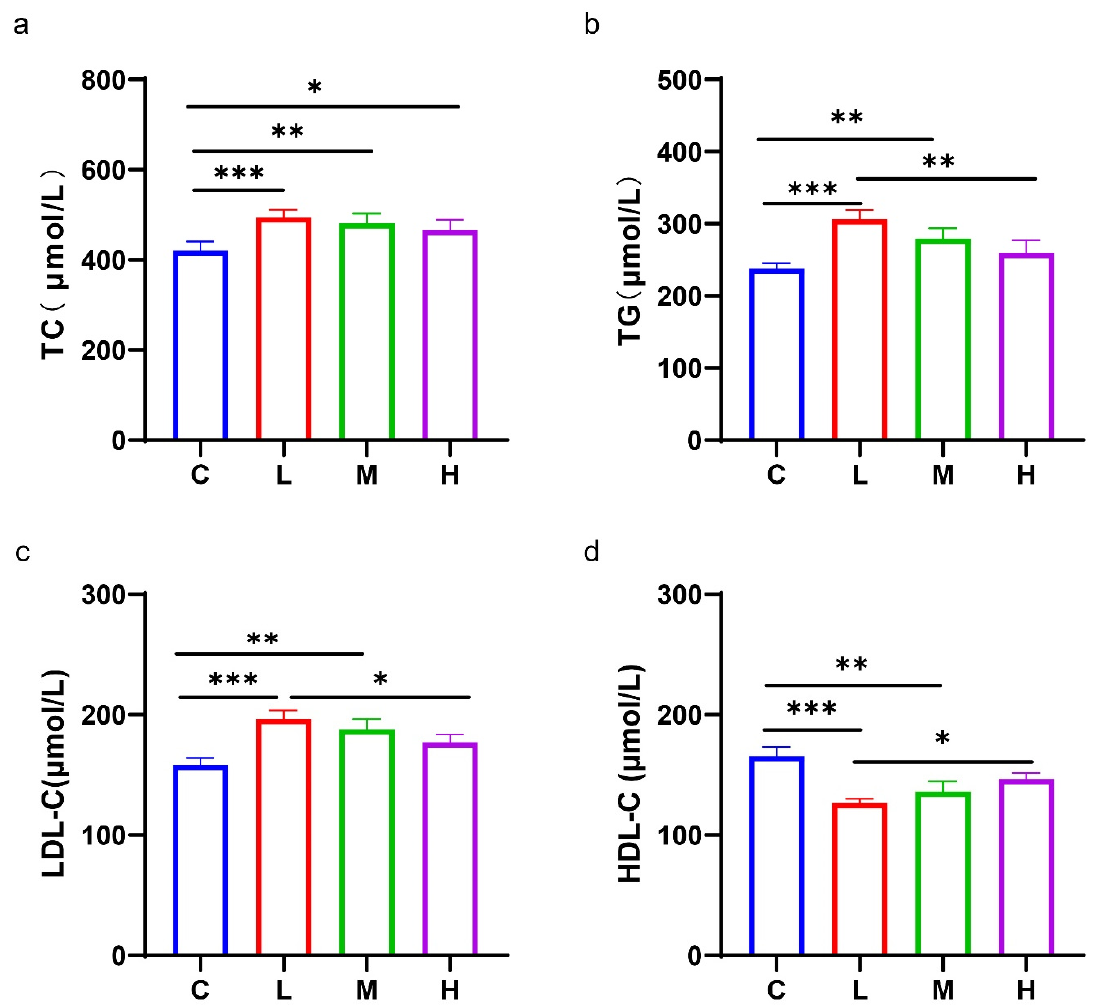
Figure 6. Impact of the CFJ supplementation on the blood lipid profile. Level of cholesterol (TC) ( a ), triglycerides (TG) ( b ), low-density lipoprotein cholesterol (LDL-C) ( c ), high-density lipoprotein cholesterol (HDL-C) ( d ) in serum ( n = 7–10, since mice have individual differences, the mice had unexpected deaths during rearing that were not related to the experimental material, and in addition, mice that had serious deviations from normal weight during rearing were excluded). * p < 0.05; ** p < 0.01; *** p < 0.001.